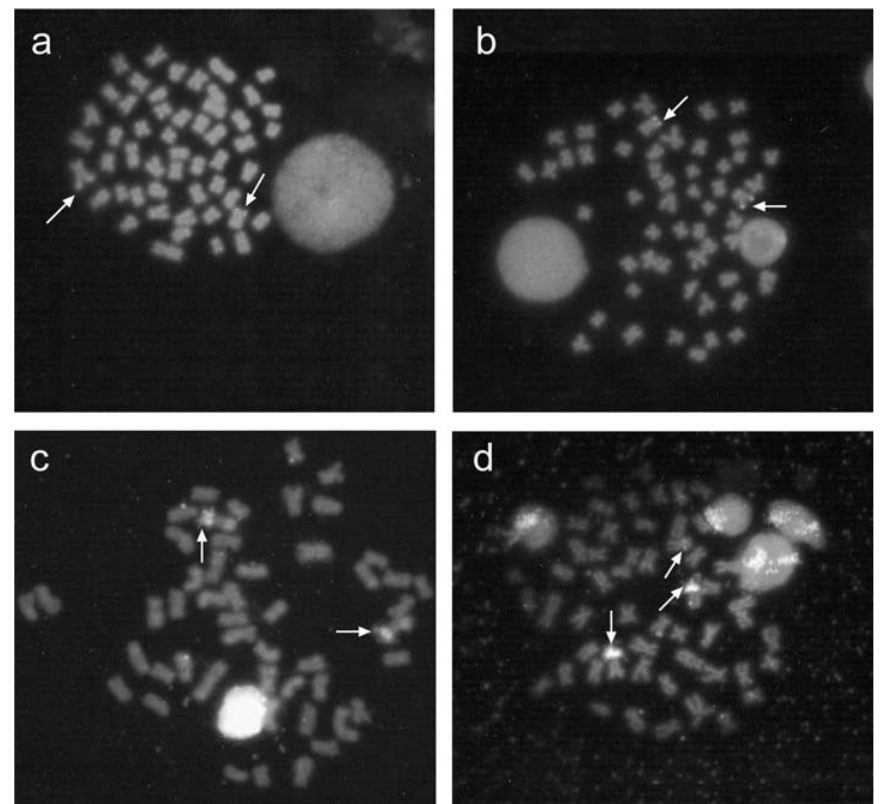
Figure 3 - Fluorescent in situ hybridization with the 18S rDNA probe (a. Parodon tortuosus and b. Parodon nasus ) and the 5S rDNA probe (c. Parodon tortuosus and d. Parodon nasus